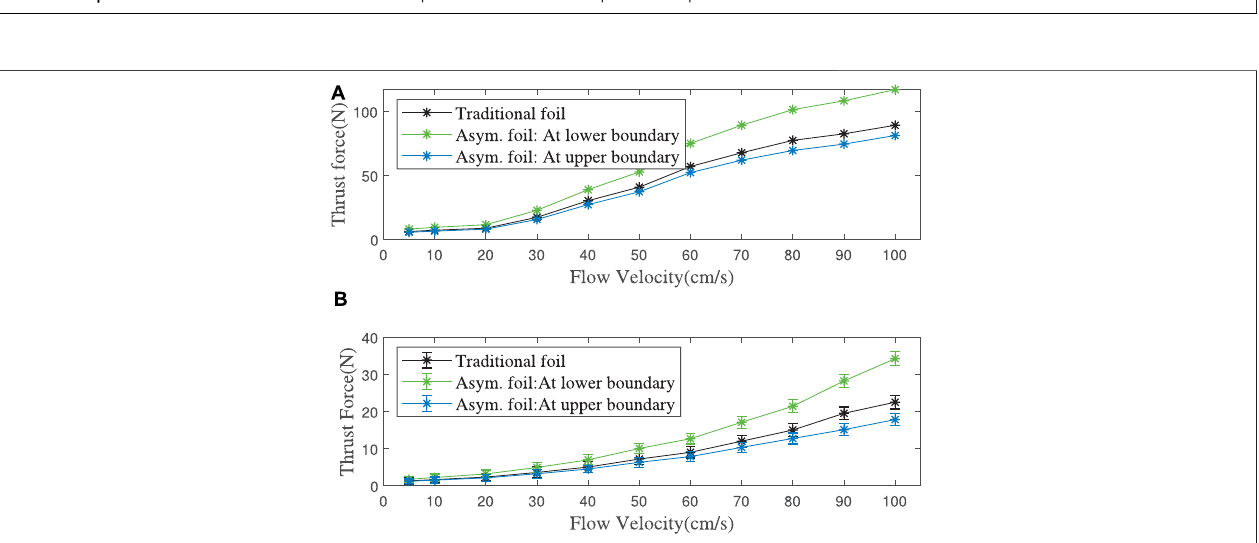
FIGURE 7 | Foils ’ rotation in a standard wave with amplitude 1.2 m and fi xed-point wave period 4 s.